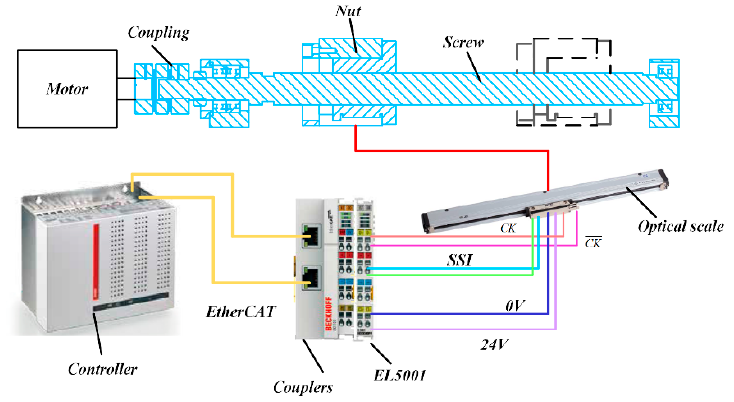
Figure 7. Principle of optical scale measurement positioning errors.